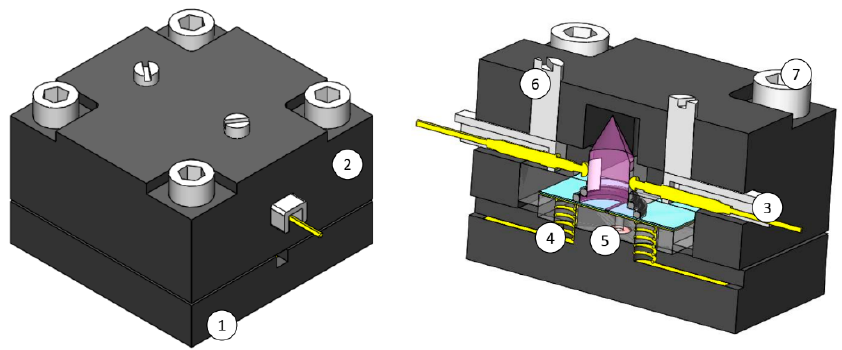
Figure 2. Isometric and cut view of the shell. ( 1 ) Bottom shell, ( 2 ) top shell, ( 3 ) lateral pin, ( 4 ) electrodes connection, ( 5 ) fluidic connections, ( 6 ) M3 pin fix screws, ( 7 ) M3 screw.